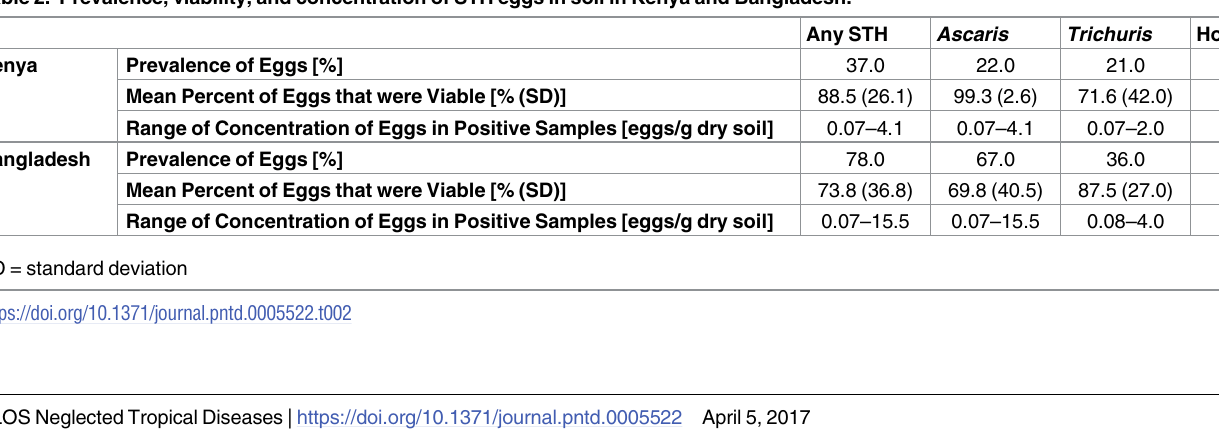
Table 2. Prevalence, viability, and concentration of STH eggs in soil in Kenya and Bangladesh. Kenya Prevalence of Eggs [%] 37.0 22.0 21.0 0 Mean Percent of Eggs that were Viable [% (SD)] Range of Concentration of Eggs in Positive Samples [eggs/g dry soil] Bangladesh Prevalence of Eggs [%] Mean Percent of Eggs that were Viable [% (SD)] Range of Concentration of Eggs in Positive Samples [eggs/g dry